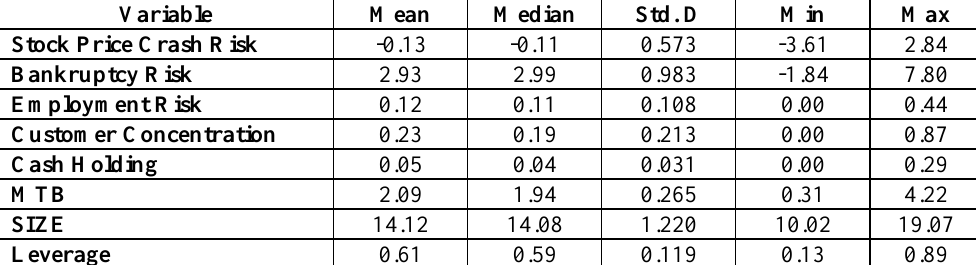
Table 2. The descriptive statistics of the research variables